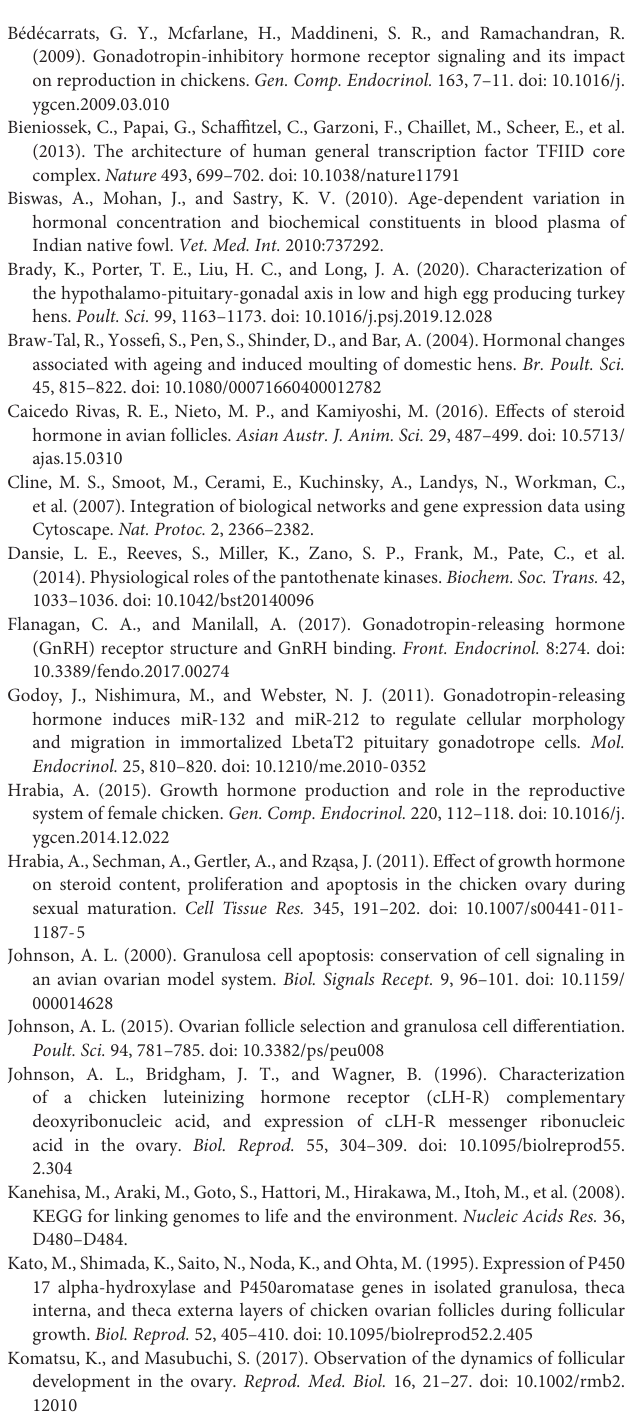
Supplementary Table 3 | The list of top 20 significantly enriched BP terms of all the DEGs in ovary.